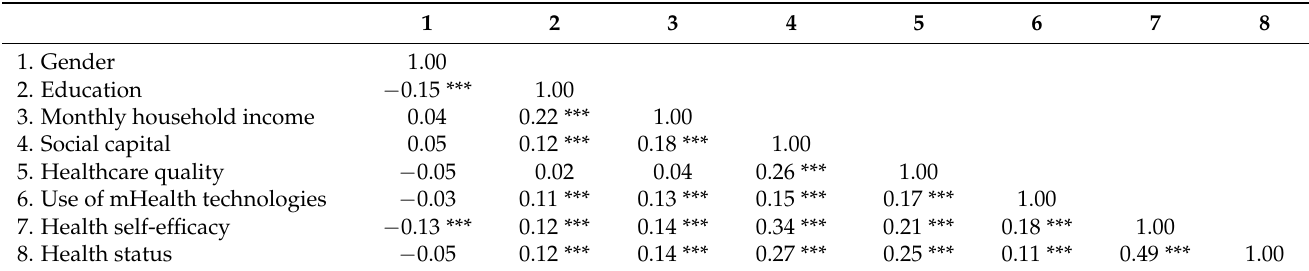
Table 2. Bivariate correlations between main variables.